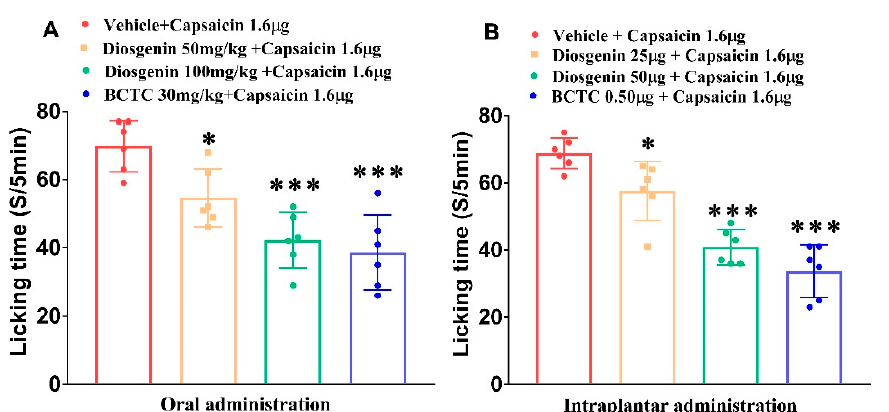
Figure 1. Oral ( A ) and intraplantar ( B ) treatment with diosgenin reduces capsaicin-induced acute licking time. BCTC: N -(4-tertiarybutylphenyl)-4-(3-cholorphyridin-2-yl) tetrahydropyrazine-1(2H)- carbox-amide. Data are presented as mean ± standard error of mean (n = 6), * p < 0.05 and *** p < 0.001, Bonferroni post hoc test following one-way ANOVA versus the vehicle + capsaicin 1.6 µ g group.